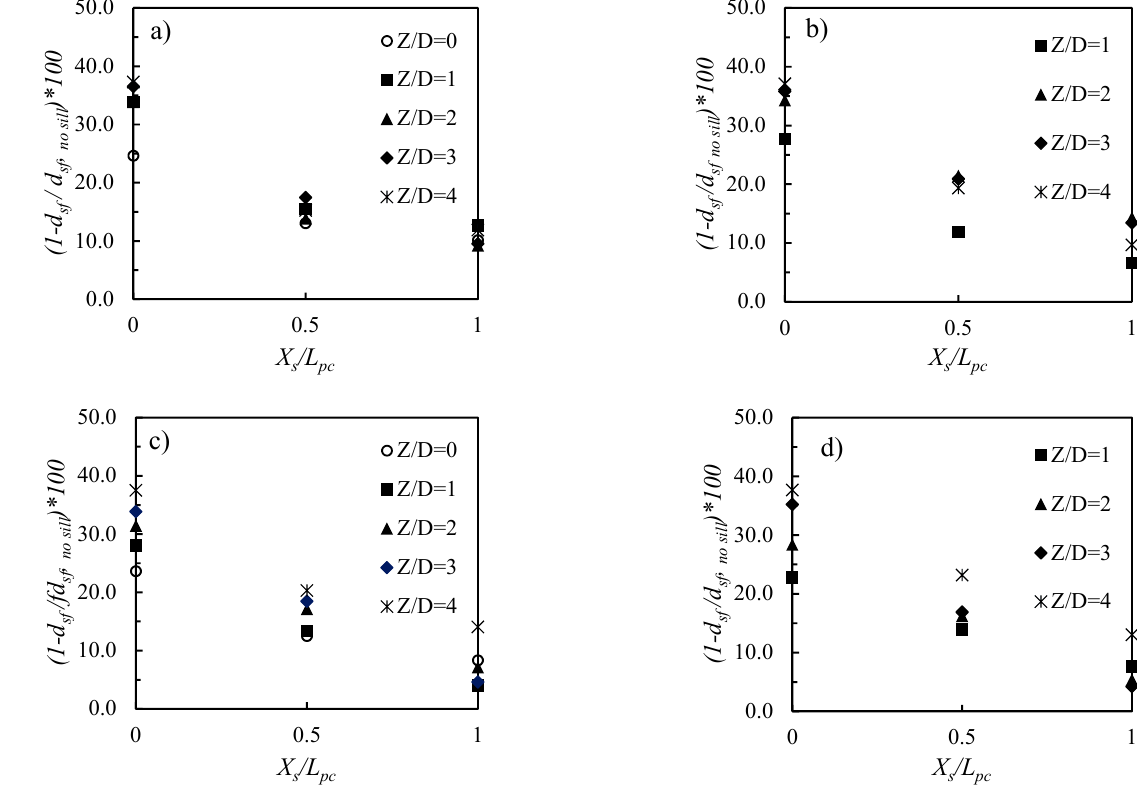
Figure 8. Comparison of maximum scour depth in conditions with and without sill for T pc / D = 0.85, d p /D = 0.57, ( a ) m = 2, ( b ) m = 3 and T pc /D = 1.42, d p /D = 0.57, ( c ) m = 2, ( d ) m = 3.